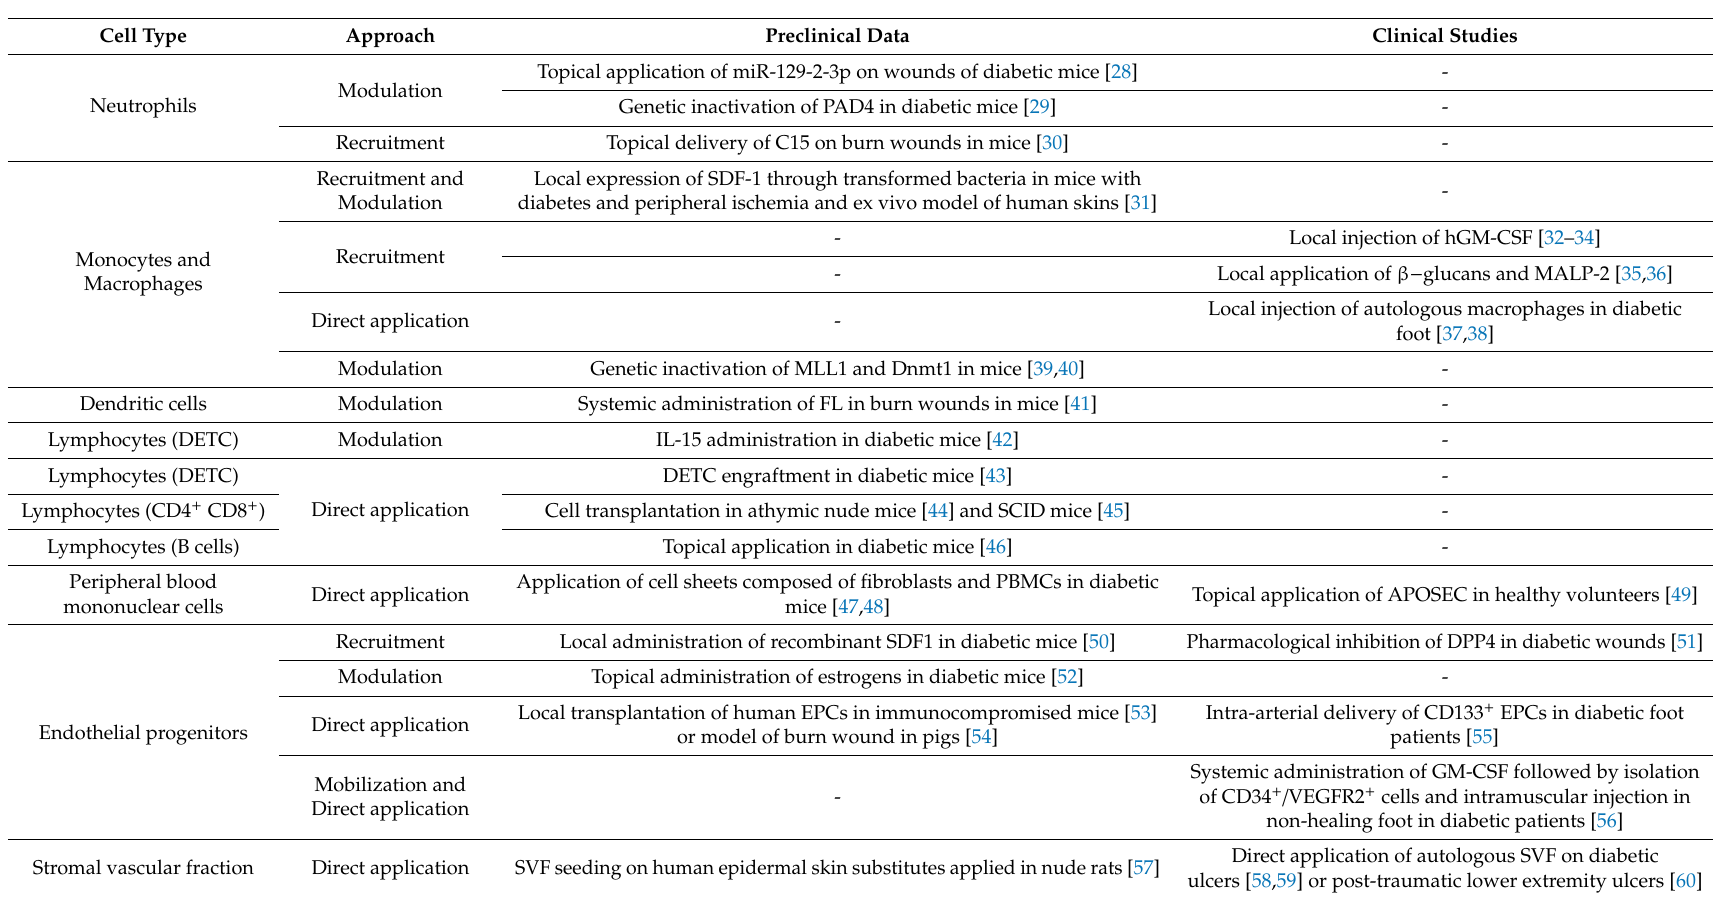
Table 1. Preclinical and clinical studies based on cell therapy for non-healing